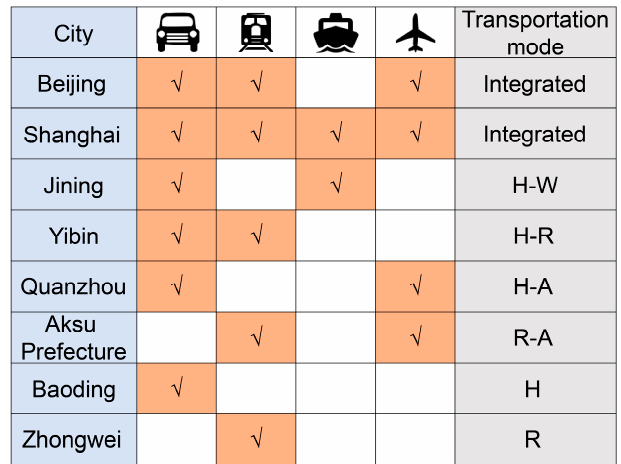
Figure 2. Principles for determining the dominant mode of transportation in Chinese cities. “Inte- grated” is a city with no less than 3 transportation hubs, “H-W” is a city with highway and waterway transportation hubs, “H-A” is a city with highway and air transportation hubs, “R-A” is a city with railway and air transportation hubs, “H” is a city with highway transportation hubs, and “R” is a city with railway transportation